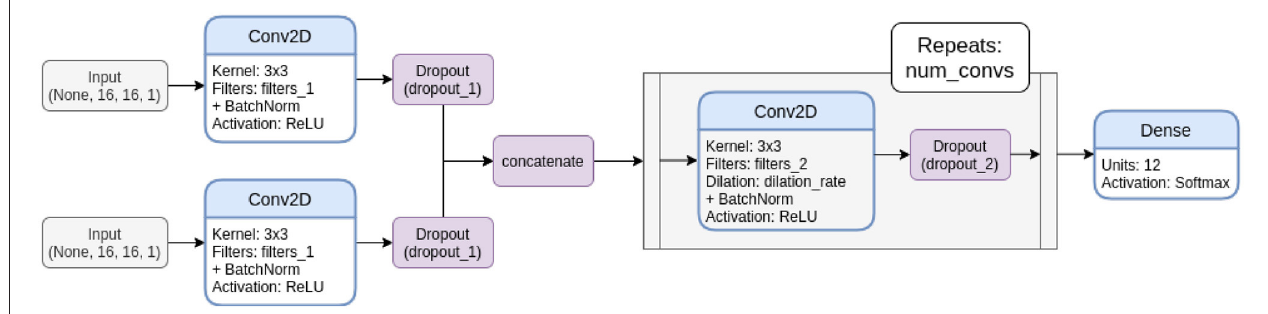
FIGURE 4 | Template network architecture for dual input CNNs. Note that this depiction shows the late fusion variant. In the early fusion variants, the inputs are concatenated directly after the input layers and processed in one branch, instead of providing an individual convolution block for both inputs before fusion.